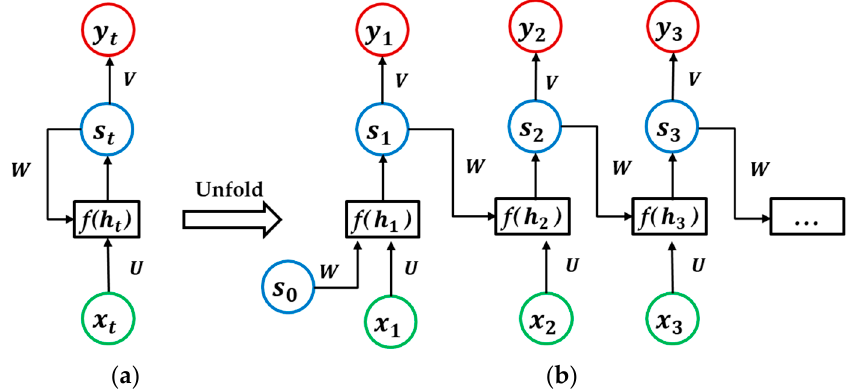
Figure 3. A standard recurrent neural network architecture (many-to-many), ( a ) is the standard unit, and ( b ) is an expanded form of ( a